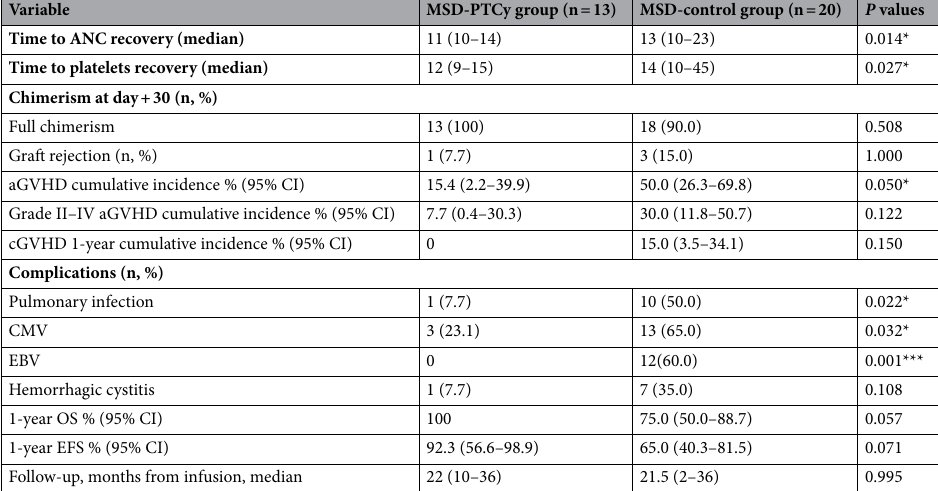
Table 3. Transplantation outcomes in MSD-HSCT groups. 95% CI 95% confdence interval. Continuous variables were expressed as median values and ranges; Discrete variables were expressed as counts (%). Cumulative incidences of aGVHD and cGVHD were estimated using competing risk model. P -value log-rank tests and Fisher exact test. * P < 0.05, *** P < 0.001.